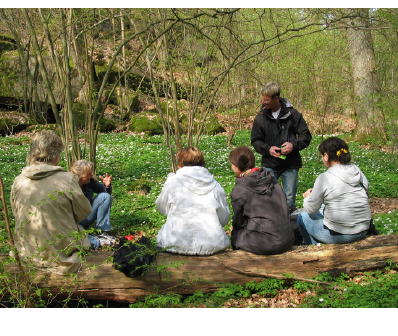
Figure 2. Education about nature during a guided nature walk (Photo Gröna